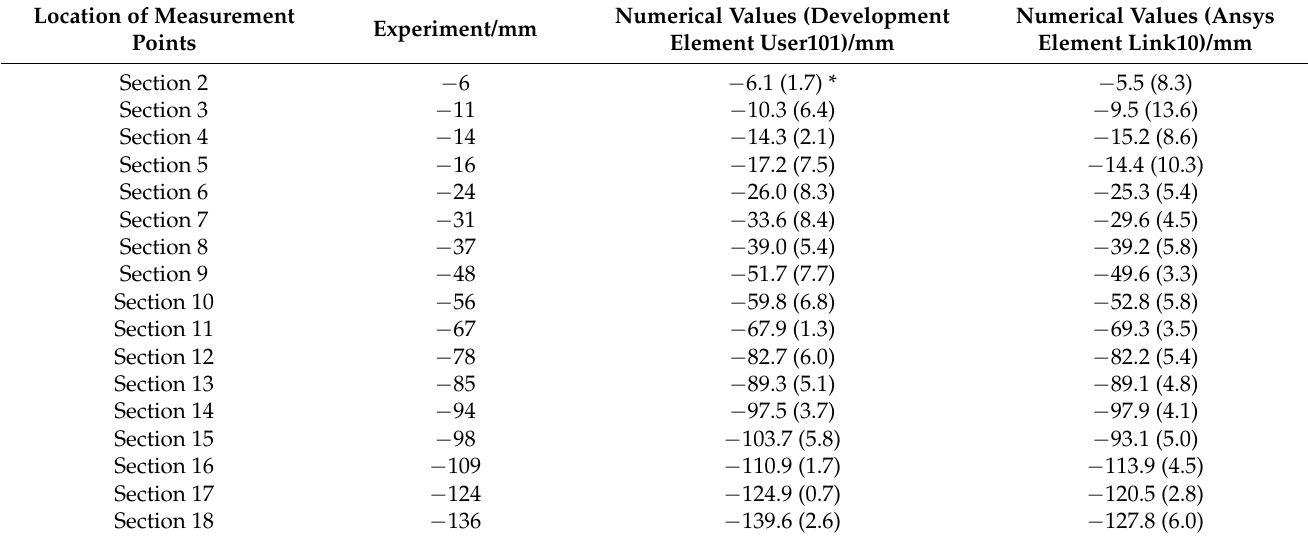
Table 7. Maximum vertical deflection of each segment of the arch ring.